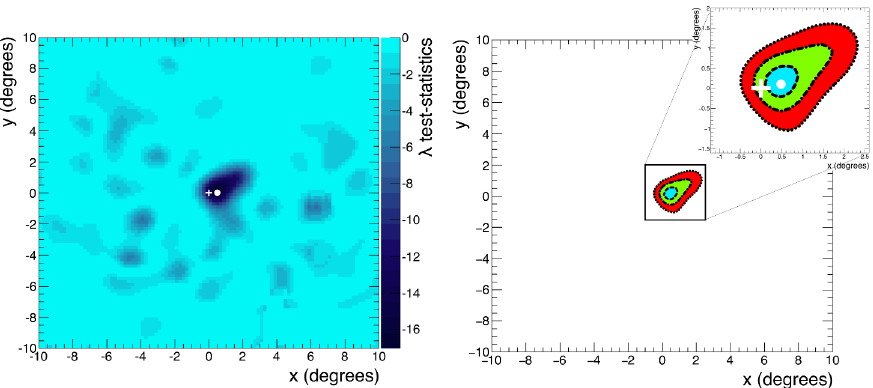
Figure 3. Left: measured distribution of the test statistic λ from equation (1) in the field of view around the Moon nominal position O ≡ (0 ◦ , 0 ◦ ), indicated by a white cross; the white dot refers to the coordinates (0 . 5 ◦ , 0 . 1 ◦ ) where the test statistics reaches the minimum. Right: contour plots corresponding to di ff erent confidence levels (cyan / dashed: 68.27%; green / dot-dashed: 95.45%; red / dotted: 99.73%); in the zoom the dot represents the position in the FoV where λ is minimum, the cross indicates the nominal position of the